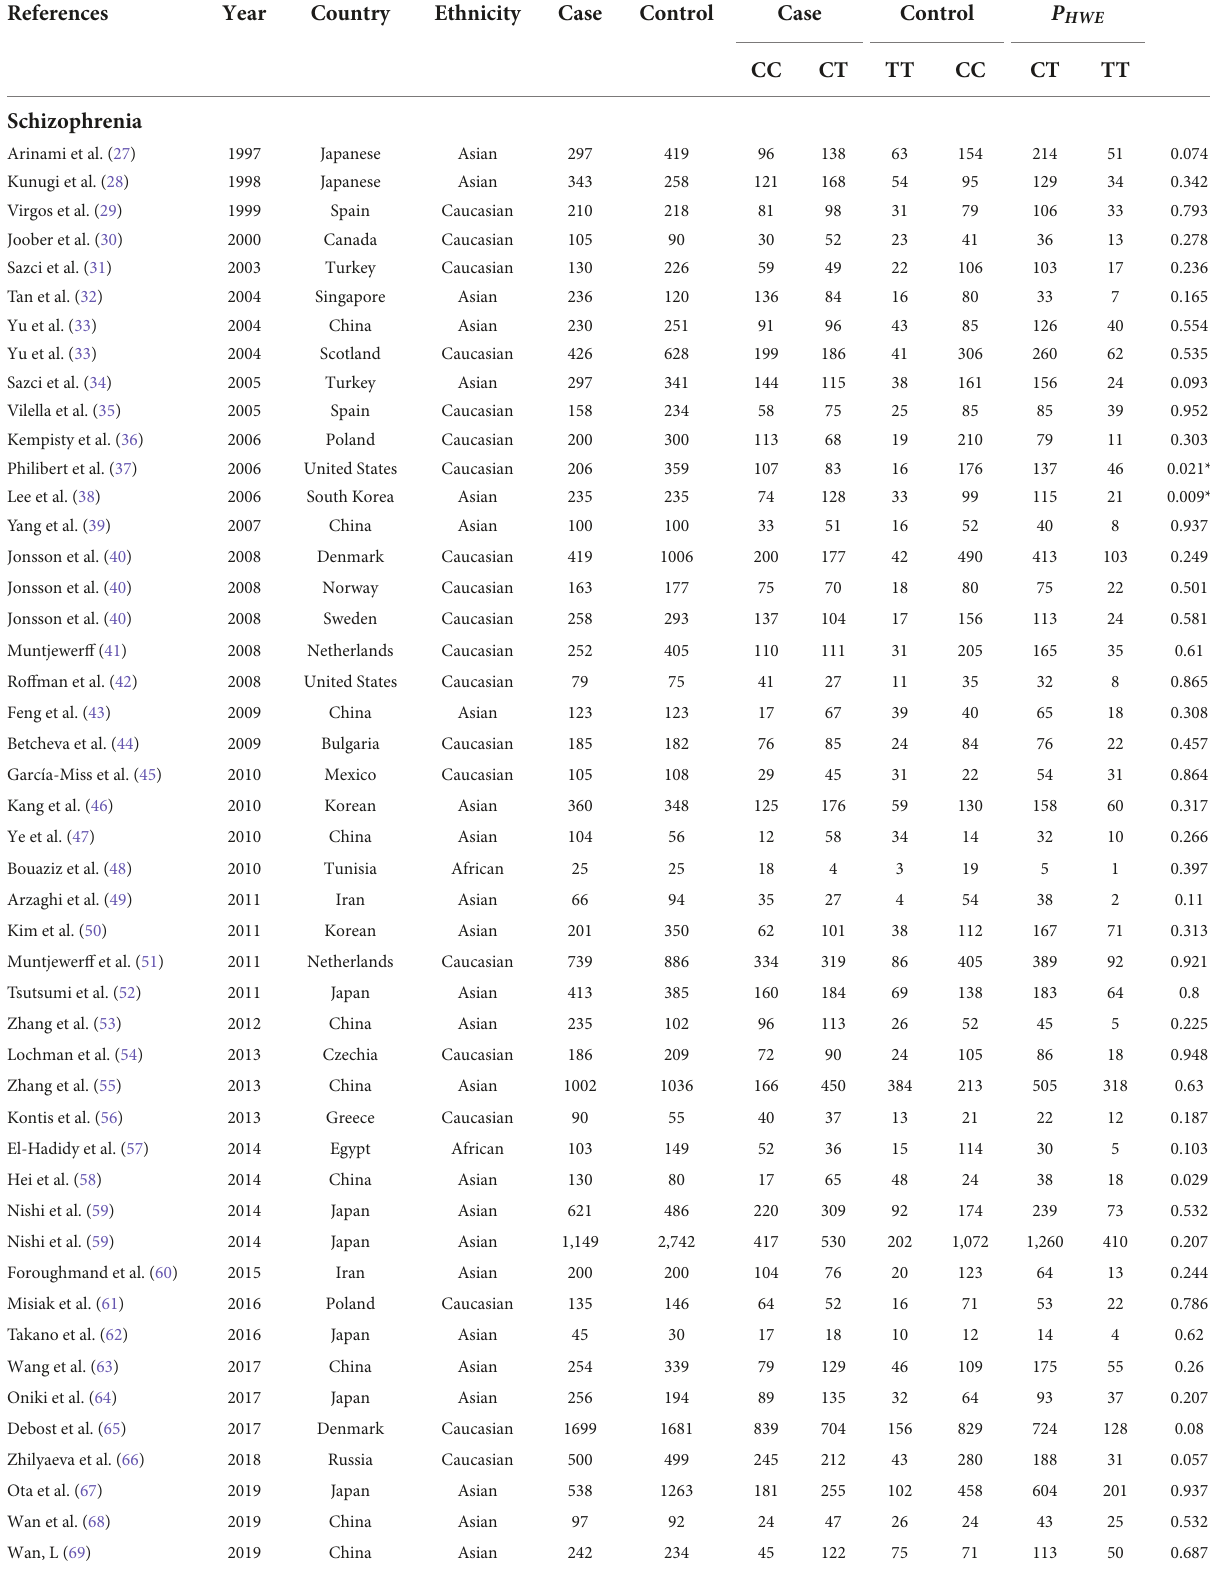
TABLE 1 Overview of MTHFR C677T genotype distribution of psychosis patients and controls, with information about country, ethnicity, and